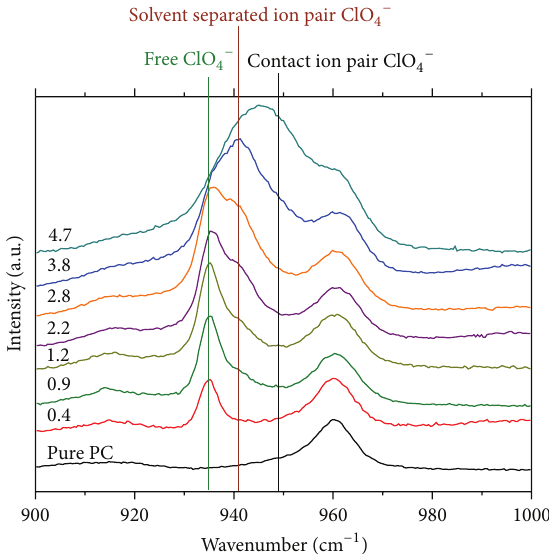
Figure 4: Raman spectra of pure PC and LiClO 4 -PC solutions of different concentrations. The concentration of all solutions is expressed as the molality of LiClO 4 (moldm −3 ) inside